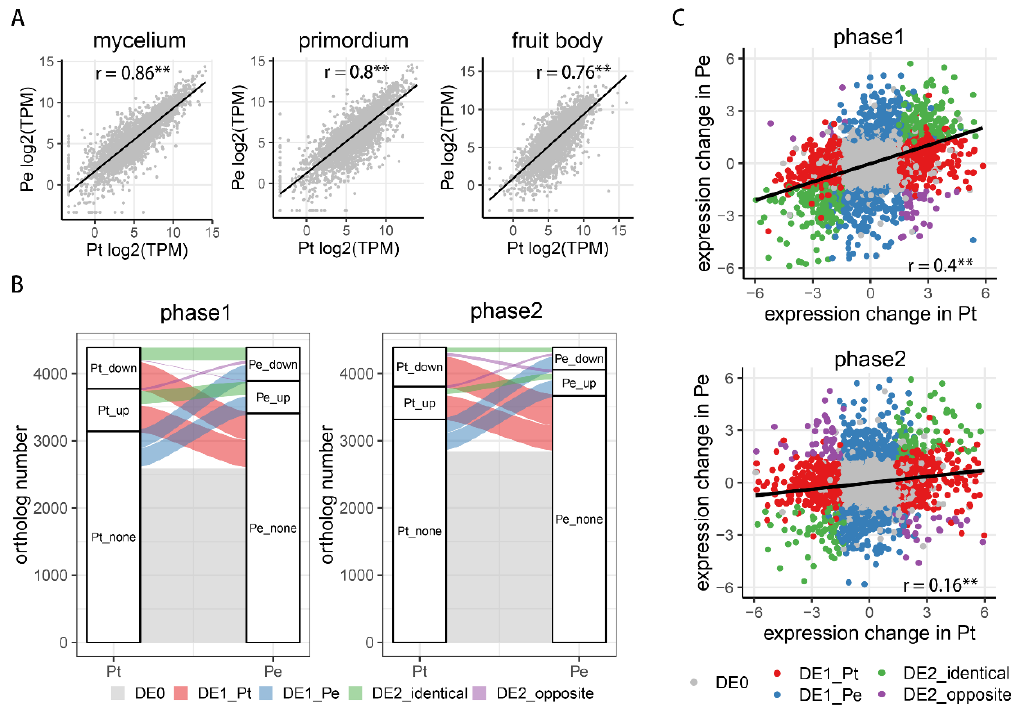
Figure 2. Expression changes between Pleurotus tuoliensis (Pt) and P. eryngii var. eryngii (Pe) in phase 1 and phase 2. ( A ) Correlation of absolute ortholog expression levels (TPM) between Pt and Pe at different developmental stages. ( B ) Alluvial diagram of orthologs expression change between Pt and Pe in each phase. Down, up and none indicating down-regulated expression, up-regulated expression and no change in expression, respectively. Alluvial with different colors represent different classes of genes. DE0: no expression changes in both orthologs; DE1-Pt: ortholog with expression change in Pt; DE1-Pe: ortholog with expression change in Pe; DE2-identical: both orthologs with expression change, identical trend; DE2-opposite: both orthologs with expression change, opposite trend. ( C ) Correlation of orthologs expression changes between Pt and Pe in each phase. The x-axis represents log2-transformed fold change between adjacent stages in Pt; the y-axis represents log2-transformed fold change between adjacent stages in Pe. The meaning of legends is same as ( B ). Asterisks in ( A ) and ( C ) indicate the p -value < 0.01 by Pearson’s product-moment correlation.